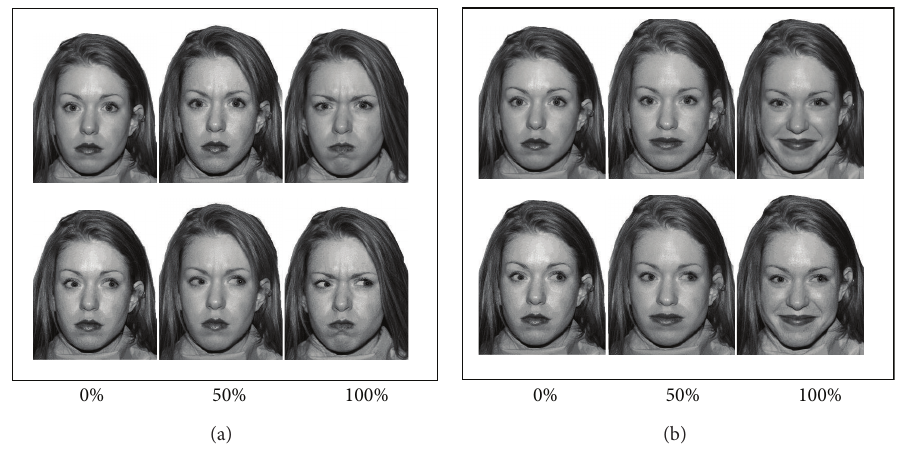
Figure 1: Examples of angry and happy expressions. Each emotional expression is presented as neutral, at 50% and 100% emotion intensity (from left to right) and with direct eye gaze (top) and averted eye gaze